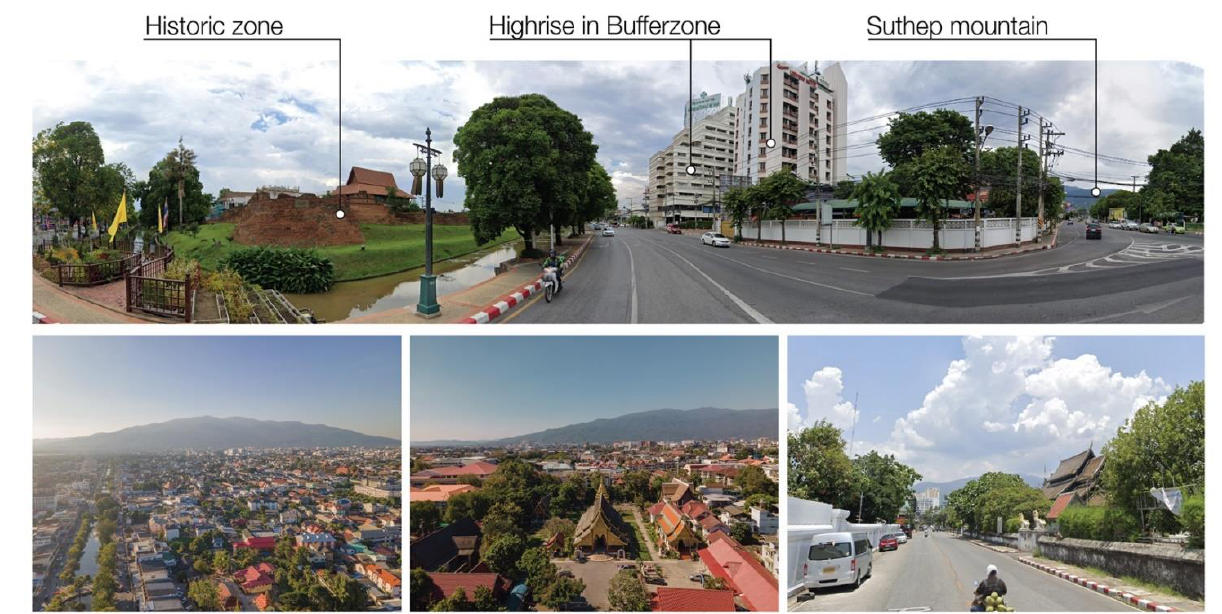
Figure 5. Existing photo from different viewing spots in the study area (Source: Authors and Reprinted/adapted with permission from Ref. [74]. 2020, CMWHI ) .